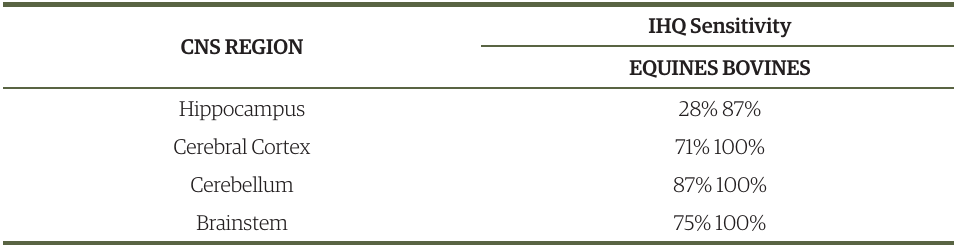
Table 4. Sensitivity of the Immunohistochemistry (IHC) in relation to the Fluorescent Antibody Test